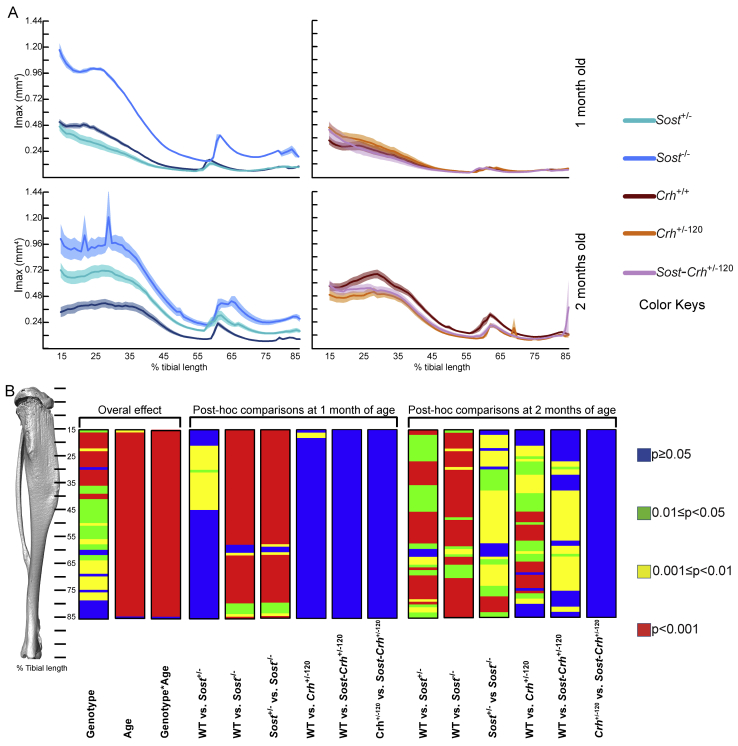
Sost haploinsufficiency does not rescue reduced area around major axis (Imax) induced by excessive glucocorticoids (GCs). A: Imax in Sost wild-type (WT) (dark blue; Sost+/+ WT), Sost heterozygous knockout (KO) (light blue; Sost+/−), Sost homozygous KO (turquoise; Sost−/−), Crh WT (dark red; Crh+/+), Crh heterozygous (orange; Crh+/−120), and double Sost-Crh heterozygous (plum; Sost-Crh+/−120) mice at 1 and 2 months of age. Lines represent the means; shading, the SEM. B: Graphic heatmap representation of statistical significance of the effect of genotype, age, their interactions as well as post hoc analysis along a 15% to 85% portion of the whole tibia length, excluding proximal and distal metaphyseal bone. n = 8 mice per group.